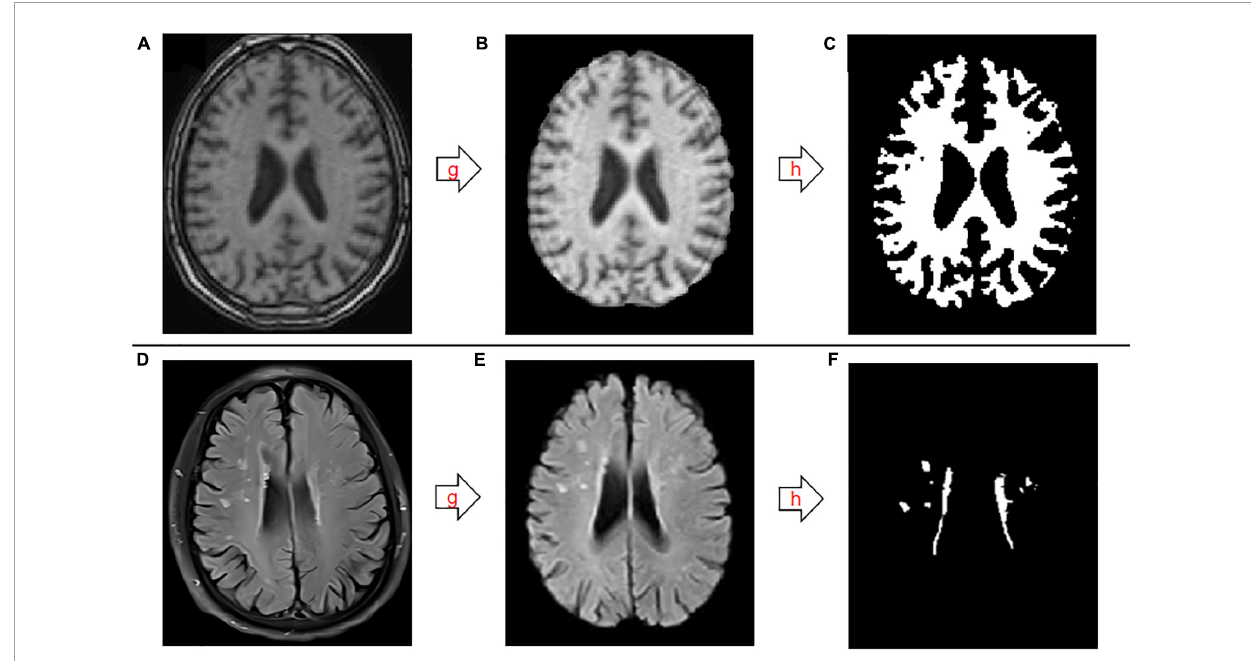
FIGURE1 Schematic diagram of the segmentation and extraction process for white matter and white matter hyperintensities. (A–C) T1-weighted images. (D–F) T2-weighted fluid-attenuated inversion recovery images. g, skull stripping; h, threshold segmentation.